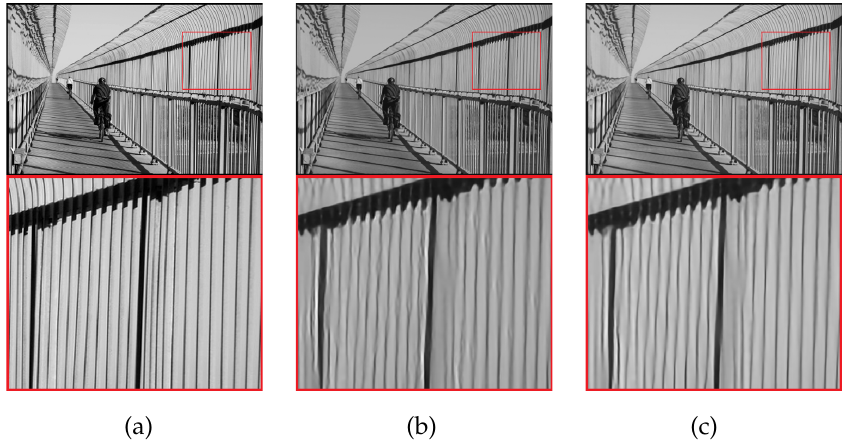
Figure 5. Super-resolution image reconstruction results. ( a ) Ground truth image. ( b ) The result of the VDSR method (PSNR = 18.94 dB). ( c ) The result of the proposed method (PSNR = 19.18